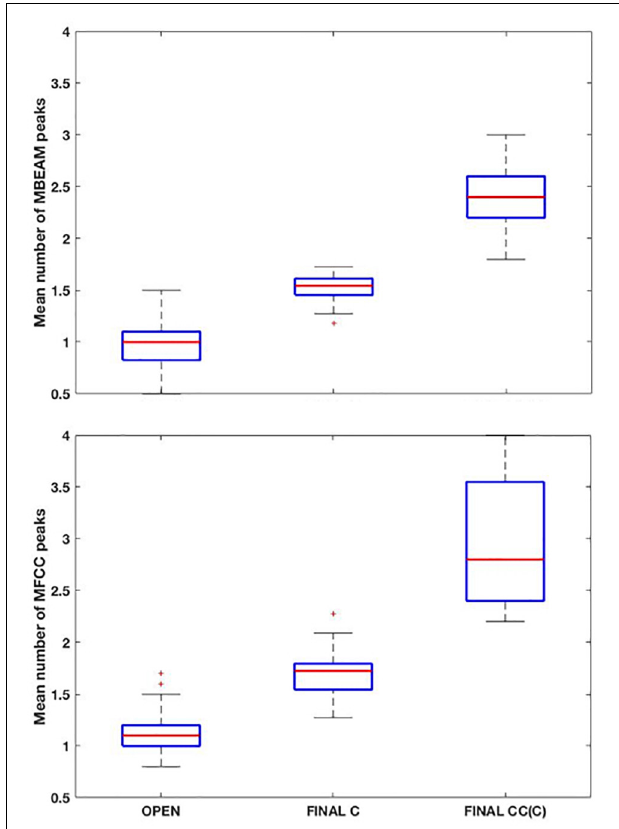
FIGURE 3 | (Top) Box plots of the mean number MBEAM peaks (pulses) per syllable as a function of syllable type: “open: (no coda consonant), “final C” (single coda consonant), “final CC(C)” (two or more coda consonants). Each speaker contributes a single value to each box plot, which is the mean number of peaks found in syllables of that type for the speaker. (Bottom) Same plots as top panel , but for MFCC peaks.